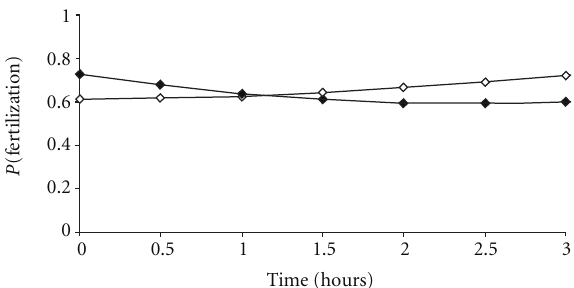
Figure 2: Influence of the timing between oocyte retrieval and denudation (white box) and the timing between oocyte denudation and ICSI injection (black box) on the fertilization rate. The relation between P (fertilization) ( P ( f ), the probability of the oocytes to be fertilized) and the time between oocyte retrieval and denudation ( T 1 ) was statistically significant with a P value < 0.0001 related to ( T 1 ) 2 . log( P ( f )) / (1 − P ( f )) = 0 . 46 + 0 . 06 ( T 1 ) 2 . The relation between P (fertilization) ( P ( f ), the probability of the oocytes to be fertilized) and the time between denudation and microinjection ( T 2 ) was statistically significant and linear with a 0.0083 P value related to T 2 , following the equation log( P ( f )) / (1 − P ( f )) = 0 . 97 − 0 . 50( T 2 ) + 0 . 11 ( T 2 ) 2 and with a 0.005 P value related to ( T 2 ) 2